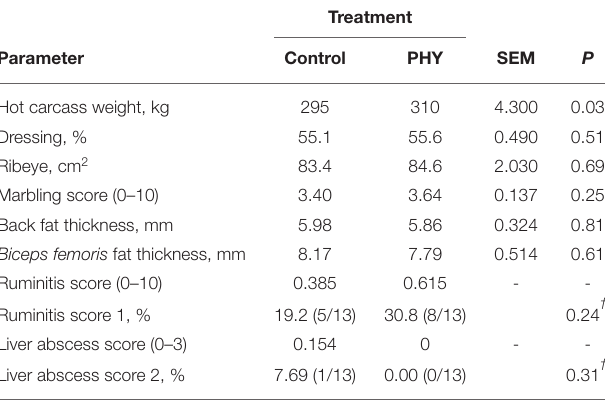
TABLE 7 | Comparison of carcass traits, ruminitis score, and liver abscess score of crossbred finishing bulls.